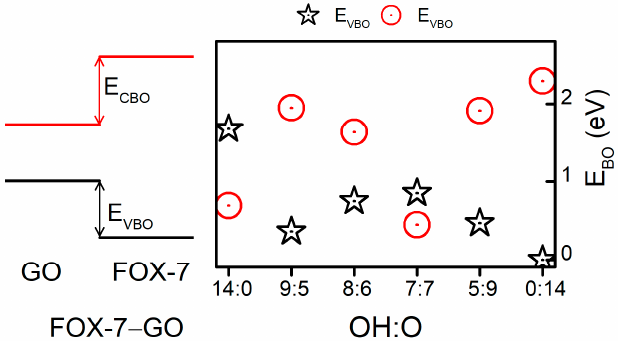
Figure 6. Band alignments of the FOX-7–GO interfaces. E CBM is the conduction band offset and E VBM is the valence band offset.